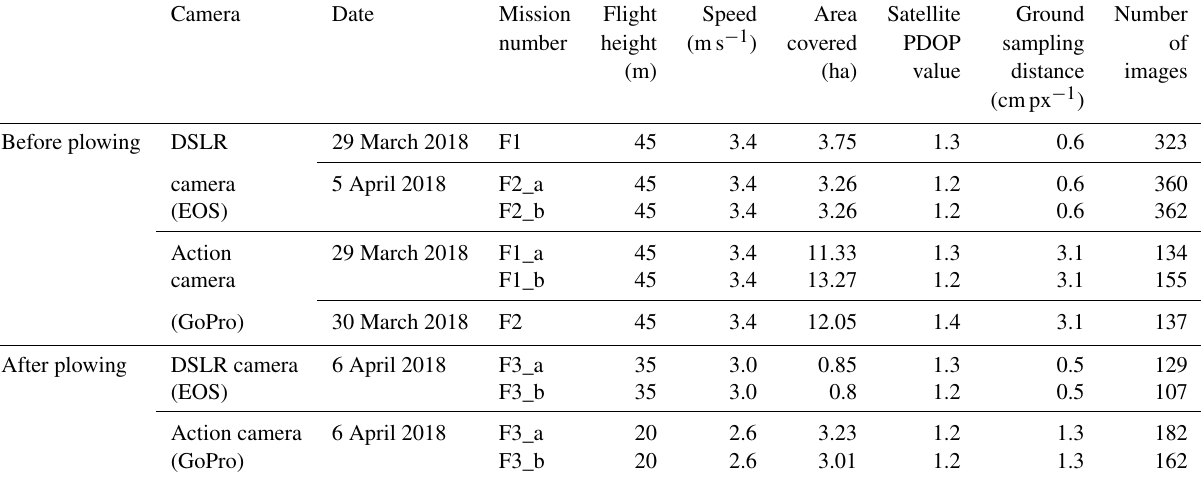
Figure 2. Experimental setup. (a) UAV–camera setup: DSLR camera (EOS 550D) mounted on RPAS type Y6, action camera (GoPro Hero 3) mounted on a Phantom 3 Advanced. (b) Parallel flight lines (top: RPAS type Y6 with DSLR camera; bottom: Phantom 3 with action camera) and GCP–CP distribution (c) . How GCPs–CPs are displayed in the images and (d) measurement of GCPs–CPs. Table 2. Overview and key parameters of flight missions. Camera Date